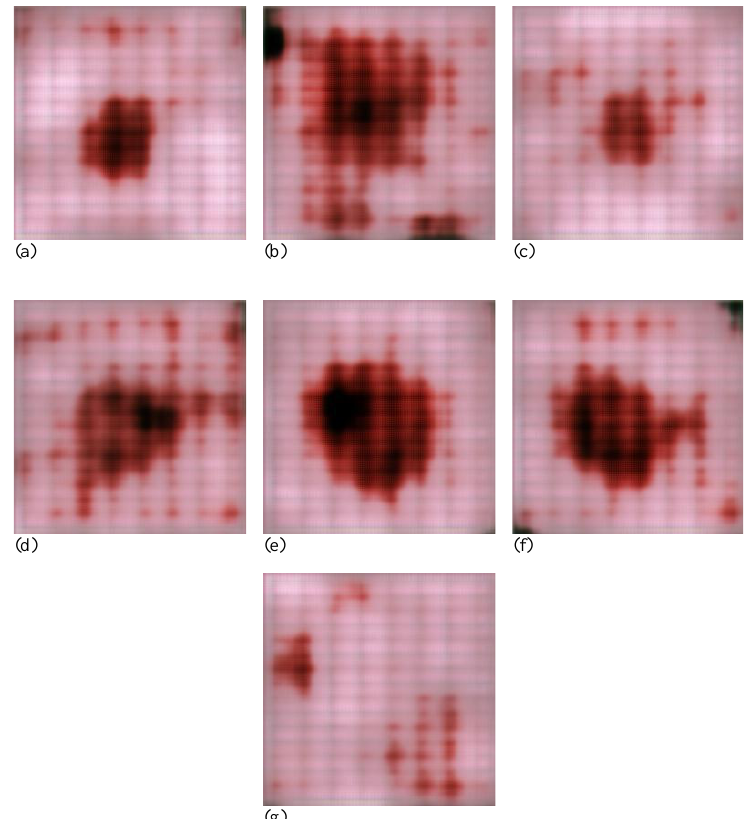
Figure 5. Some of the synthetic images from CGAN. ( a ) AKIEC; ( b ) BCC; ( c ) BKL; ( d ) DF; ( e ) MEL; ( f ) NV; and ( g ) VASC.